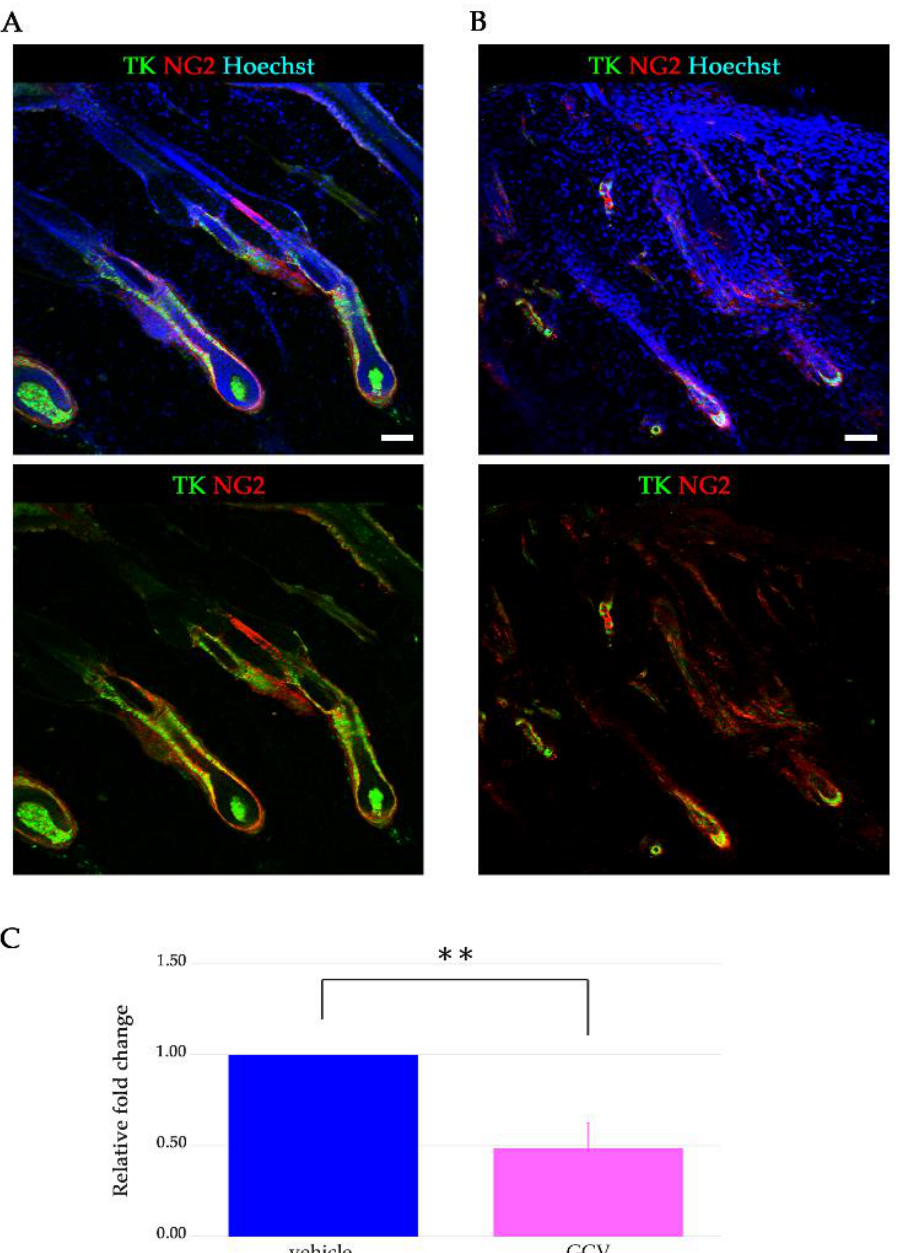
Figure 3. Morphology of the hair follicles in the GCV- or vehicle-applied skin of NG2-HSVtk Tg rats. ( A , B ) Immunostaining for HSVtk (green), NG2 (red), and Hoechst (blue) of vehicle-applied ( A ) and GCV-treated ( B ) skin sections. Upper panels: staining images for HSVtk (green), NG2 (red), and Hoechst (blue). Lower panels: staining images for HSVtk (green) and NG2 (red). Scale bars, 100 µ m. ( C ) Gene expression of NG2 in vehicle-treated skin (blue bar, n = 4) and GCV-applied skin (pink bar, n = 4) of Tg rats at 7 days. Data are mean ± SEM. ** p < 0.01.